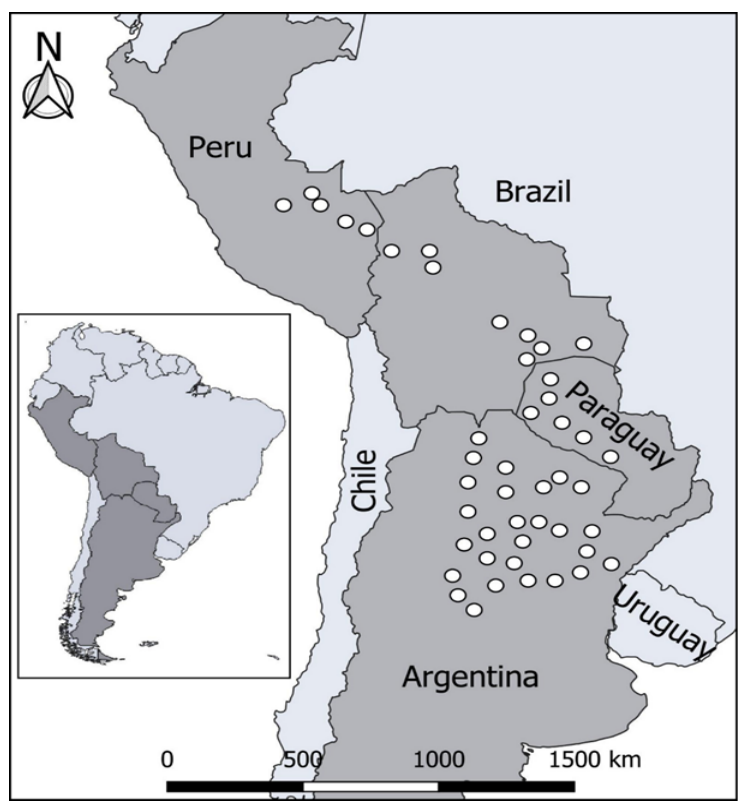
Figure 1. Mistol distribution map in South America.